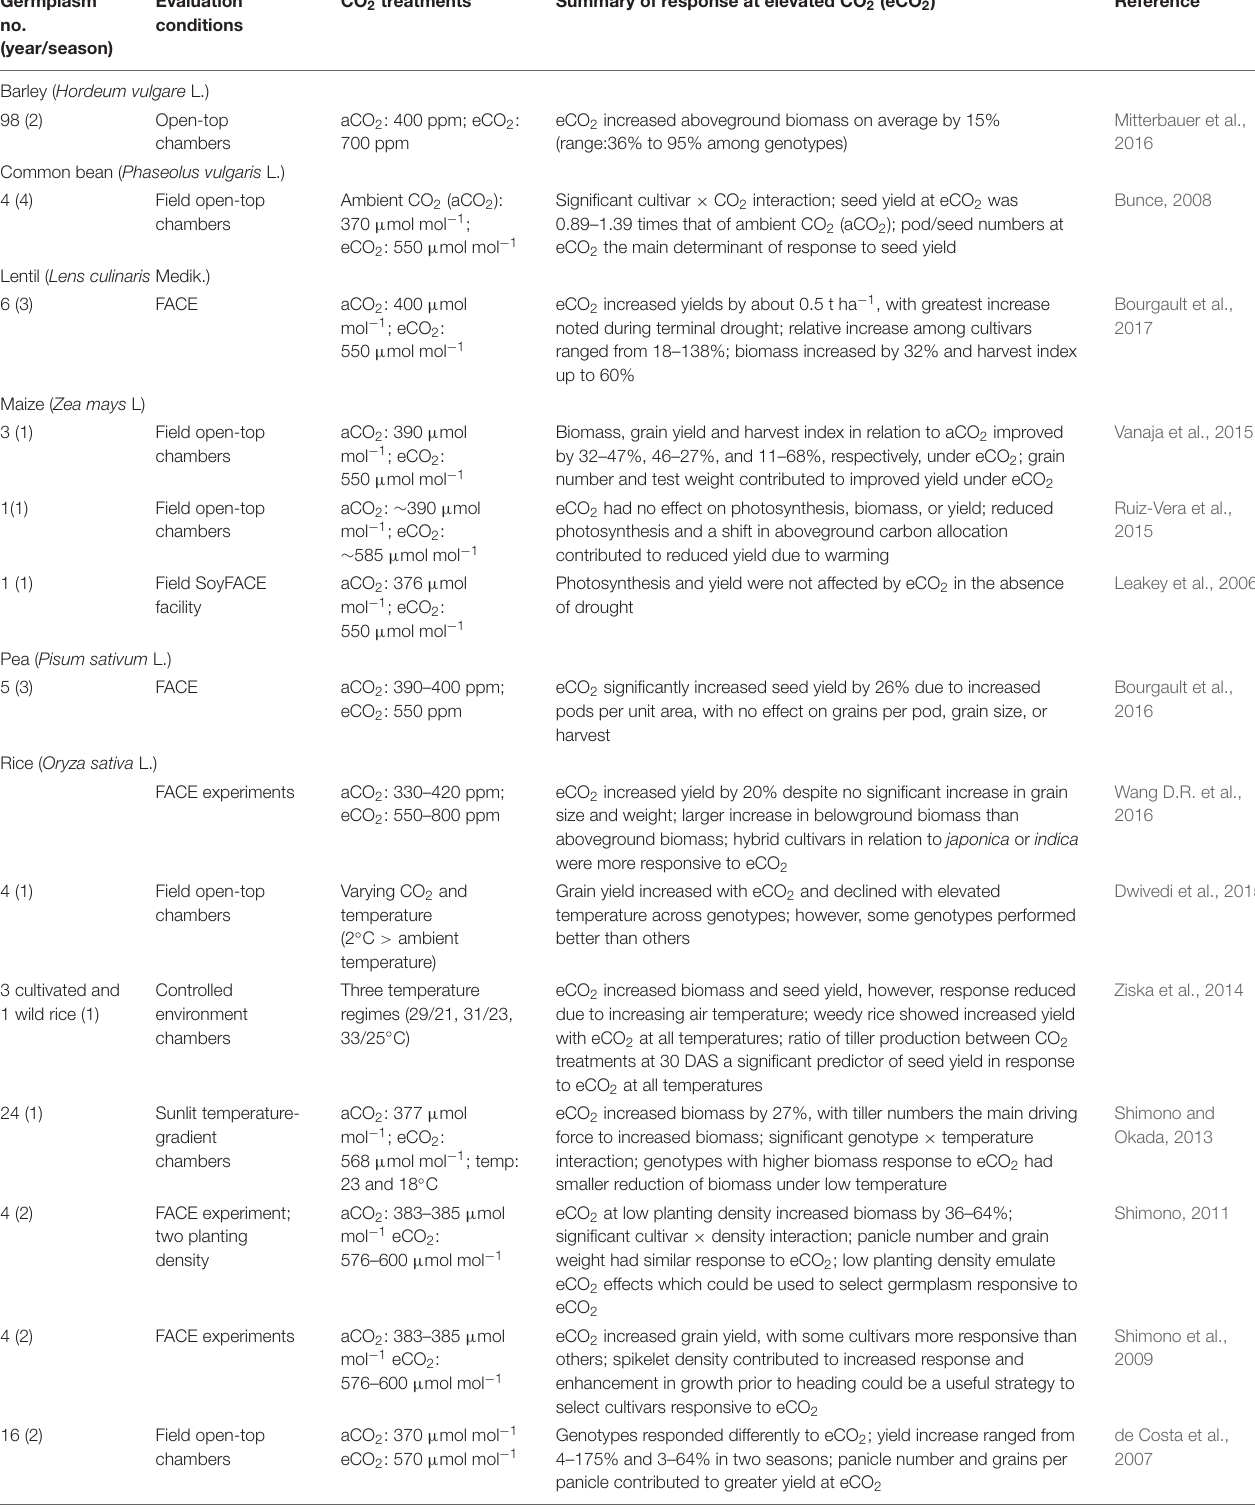
TABLE 3 | Cultivars response to elevated carbon dioxide (eCO 2 ) relative to ambient carbon dioxide (aCO 2 ) in barley, common bean, lentil, maize, pea, rice, soybean, and wheat from 2007–2017. Germplasm